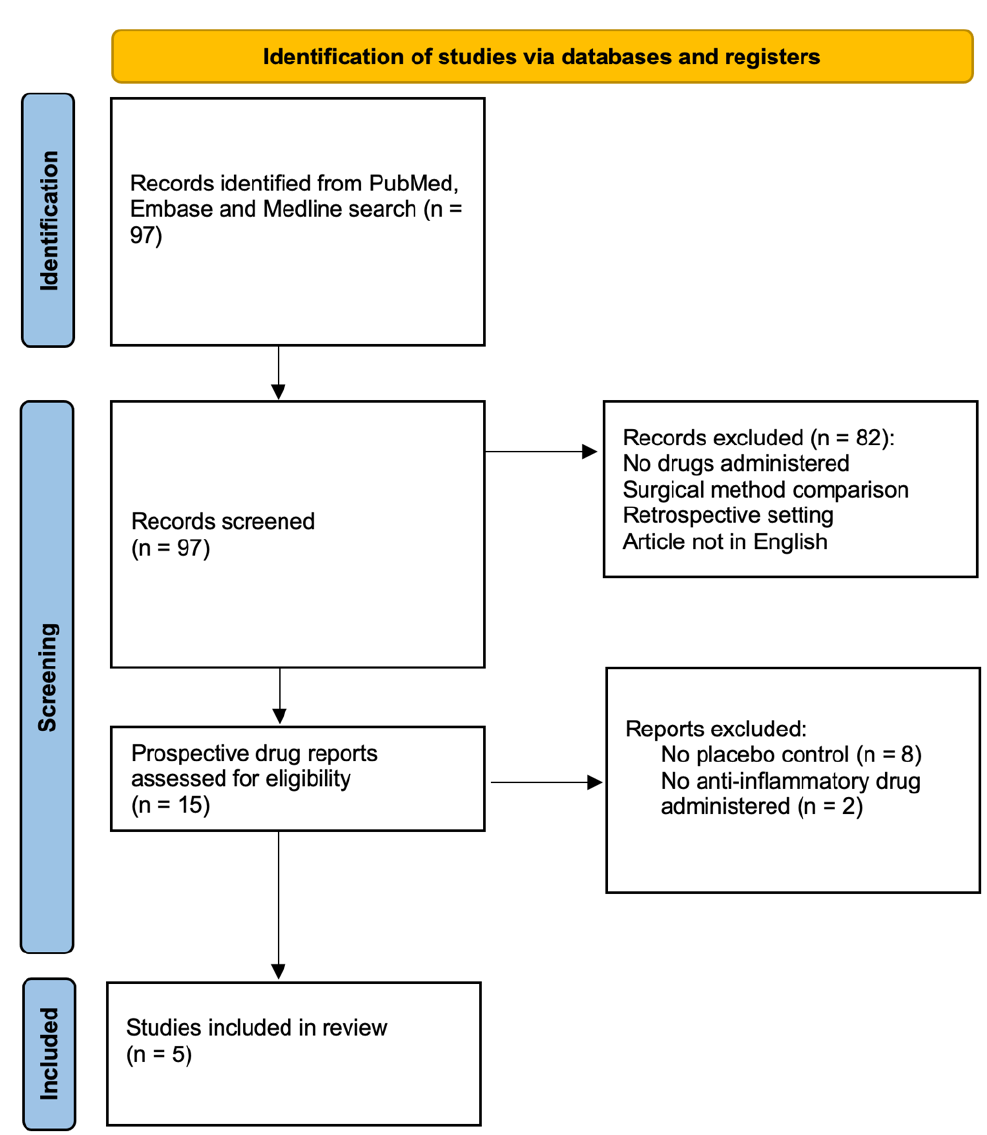
Figure 1. PRISMA flow chart illustrating the study selection.